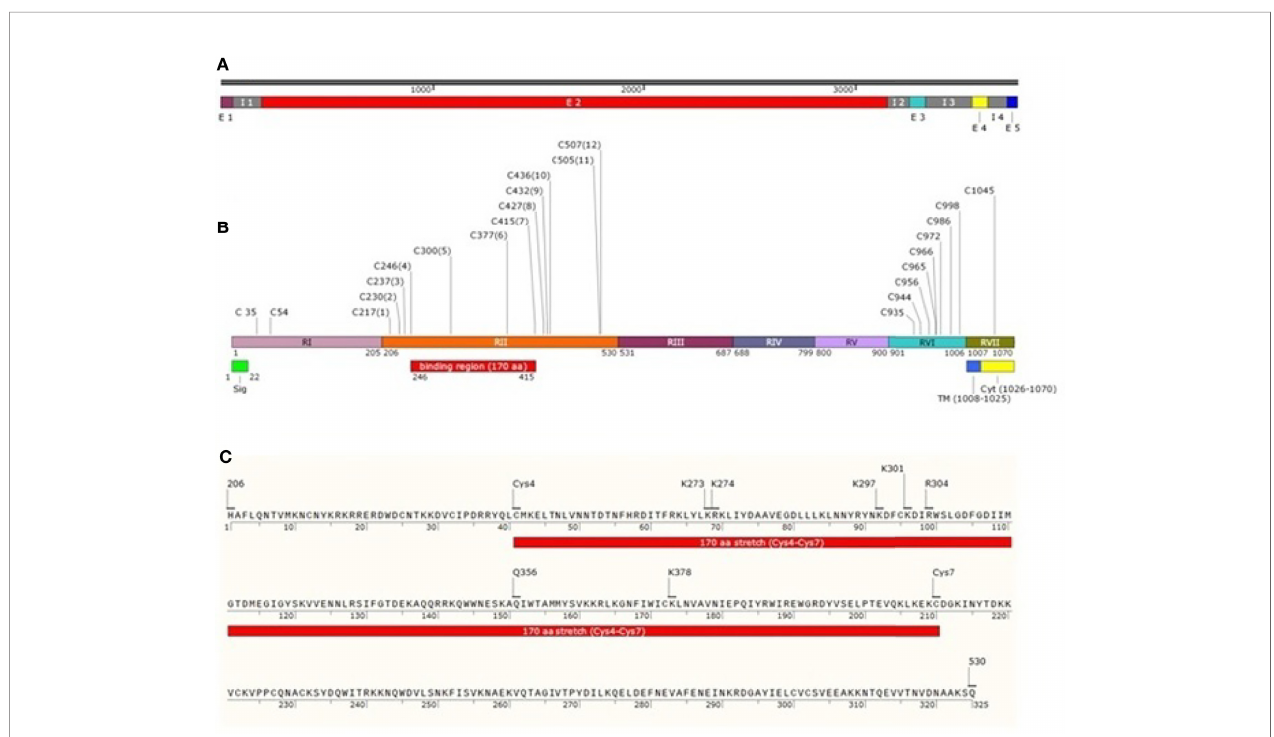
FIGURE 1 | Schematic drawing of Pv DBP. (A) Pvdbp gene (3762 nucleotides) with 5 exons (1-57, 193-3151, 3257-3335, 3554-3627 and 3719-3762, respectively) and 4 introns (58-192, 3152-3256, 3336-3553 and 3628-3718, respectively). (B) Pv DBP consisting of 1070 amino acid residues. The shared boundaries for regions I-VII (205, 530, 687, 799, 900, 1006 and 1070 amino acids, respectively) (Adams et al., 1992; Okenu et al., 2005). Labelled in it are the positions corresponding to seven regions (RI-RVII) of Pv DBP, the cysteine-rich regions (RII and RVI), signal peptide shaded in green (1-22aa), transmembrane domain shaded in blue (1008-1025aa) and cytoplasmic domain shaded in yellow (1026-1070aa). Pv DBP consists of 23 cysteines (two in RI, twelve in RII, eight in RVI and one in RVII). The cysteines are labelled along with their amino acid position. The binding residues map to a 170 aa stretch which starts from Cys4 and ends at Cys7 (C246-C415) (C) Pv DBPII spans a length of 325 aa from 206-530aa (Adams et al., 1990). The Pv DBPII binding residues at sub domain 2: Site 1 (K297, K301, R304 and K378 (VanBuskirk et al., 2004b)) and Site 2 (K273, K274 and Q356 (Hans et al., 2005)) are responsible for reticulocyte binding with respect to 1070 aa residues of Pv DBP (NCBI protein id: